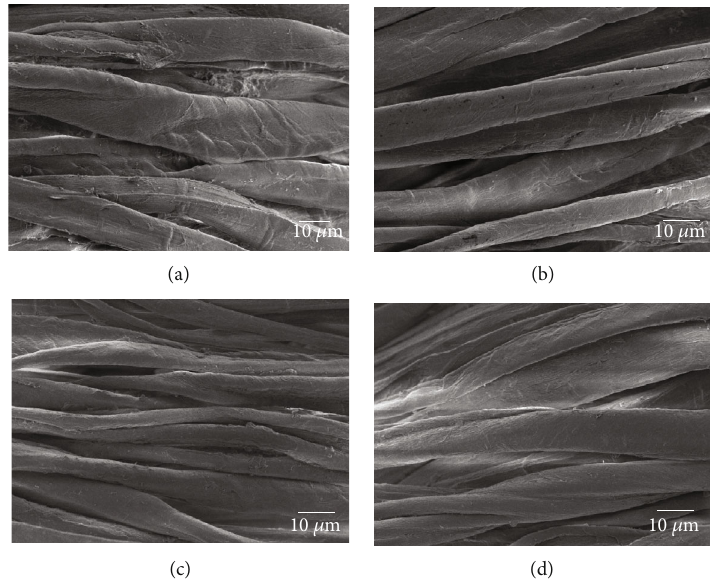
Figure 5: SEM images of fabrics after (a) 5, (b) 10, (c) 15, and (d) 20 wash